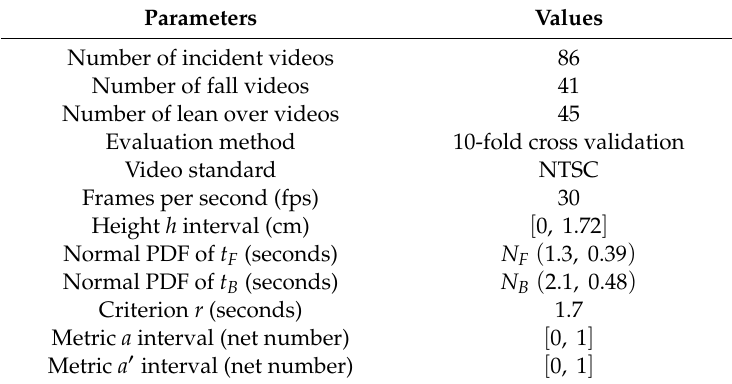
Table 3. Experimental